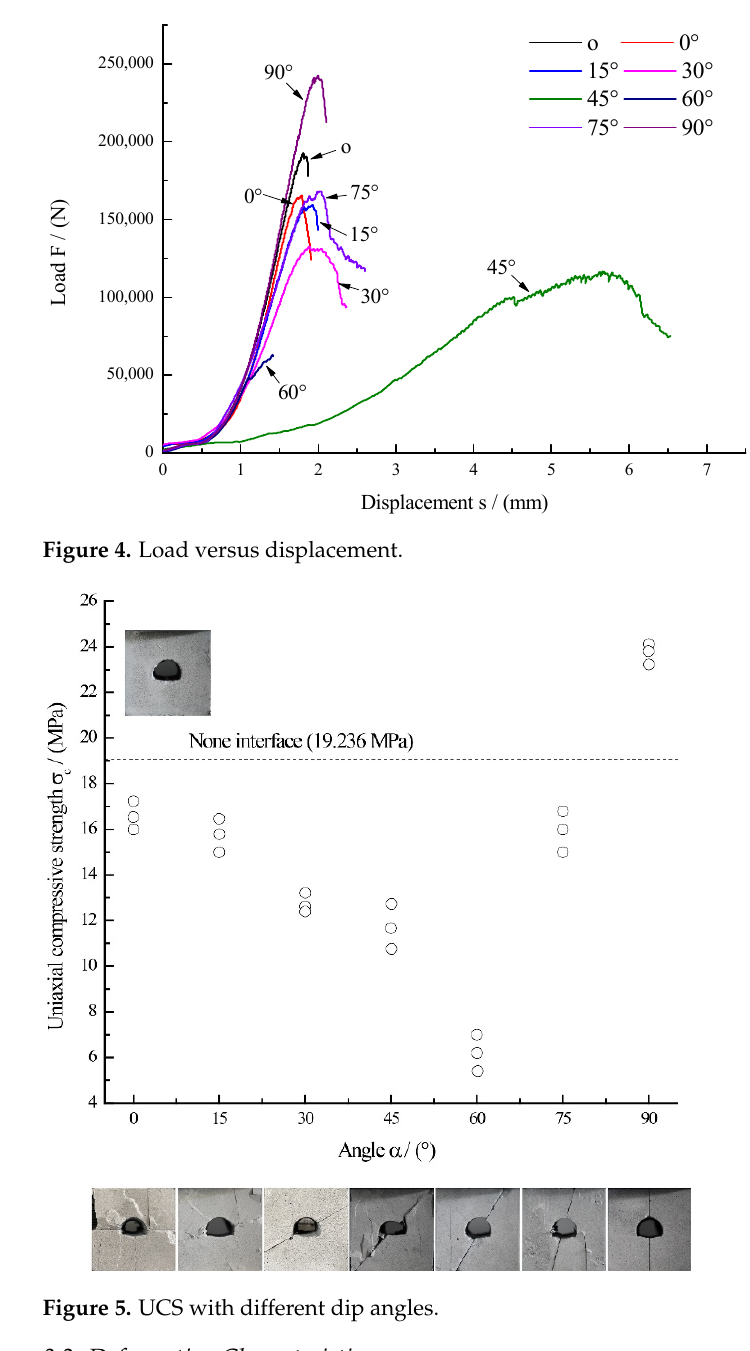
Figure 4. Load versus displacement.